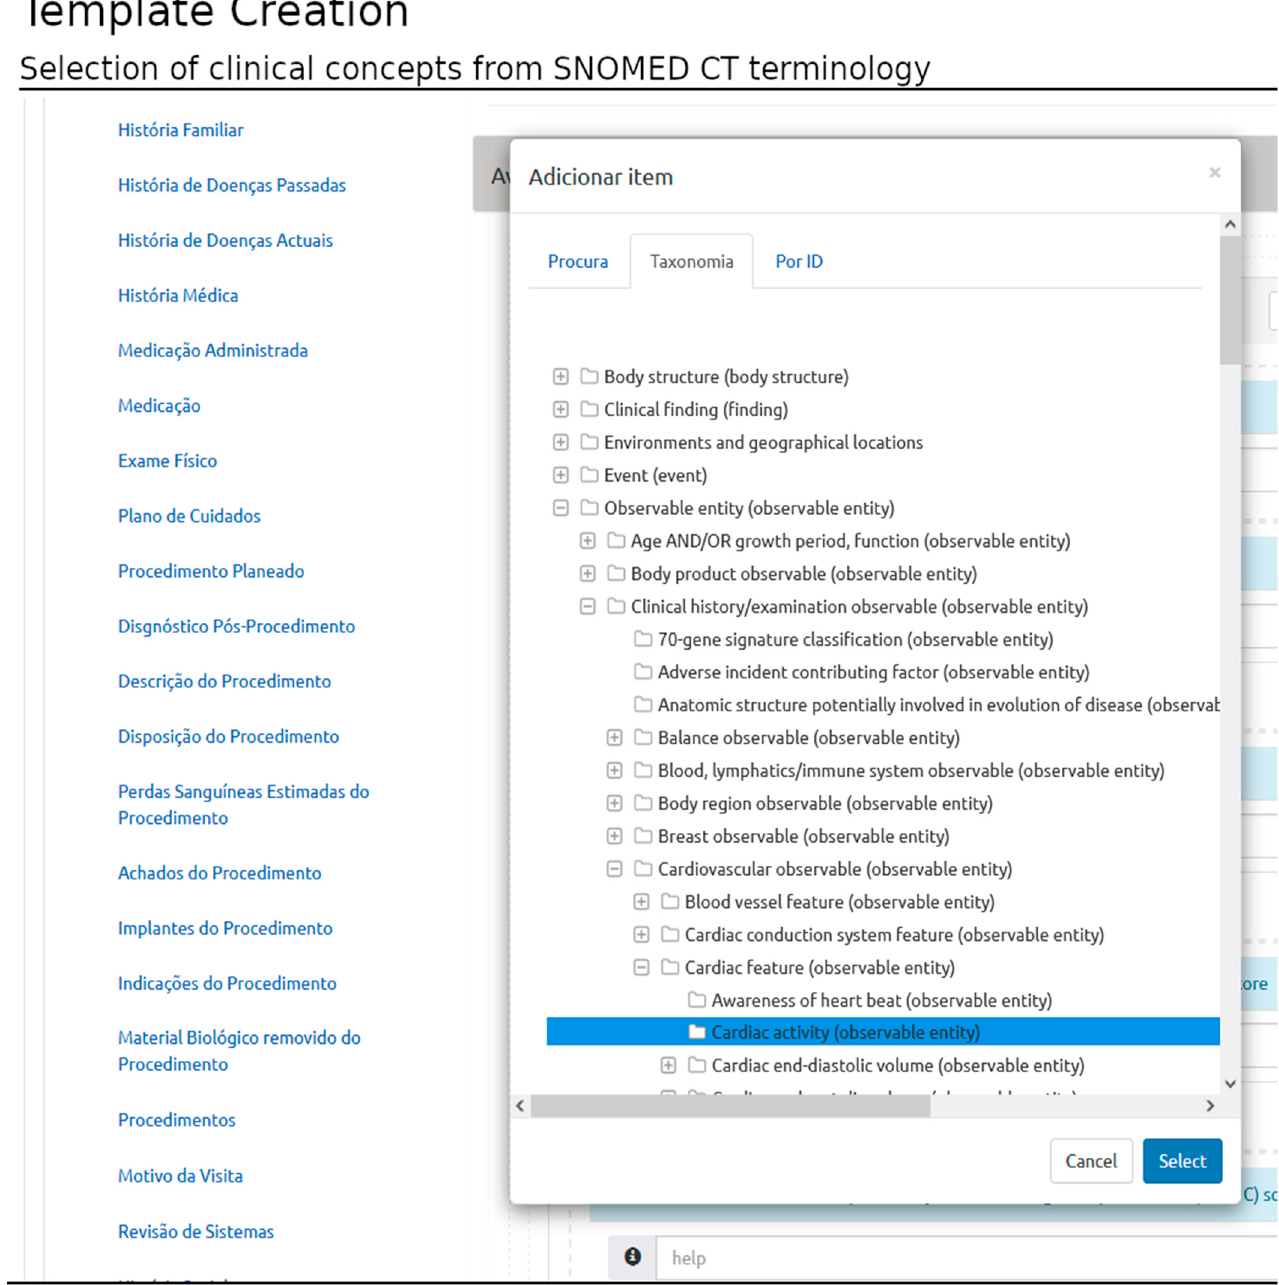
Figure 4. Template building: inclusion of clinical concepts based on the SNOMED CT standard.